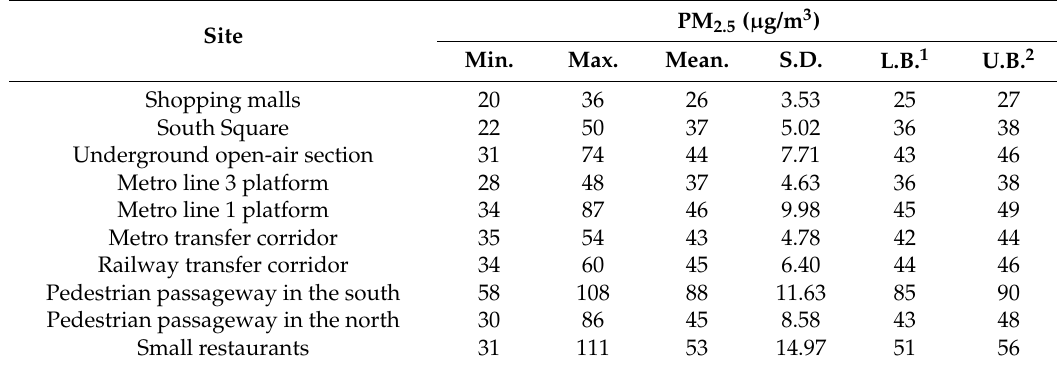
Table 4. The minimum, maximum, average PM 2.5 concentrations, the standard deviation, and confidence interval for sampling